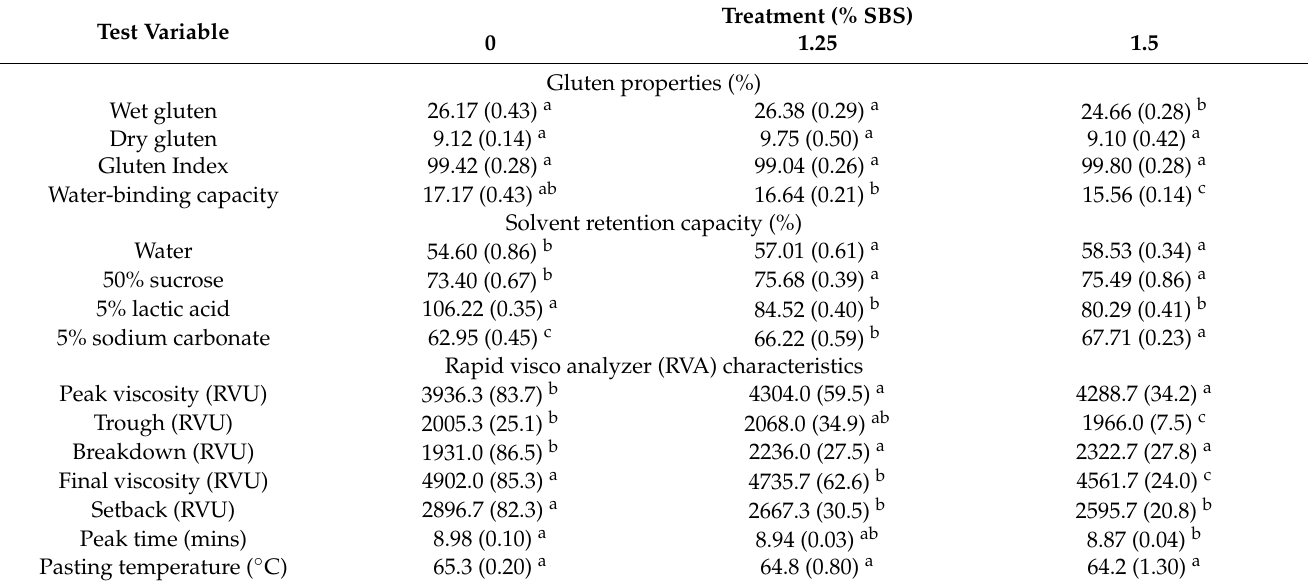
Table 5. Mean (sd) gluten, solvent retention capacity, and RVA characteristics of wheat